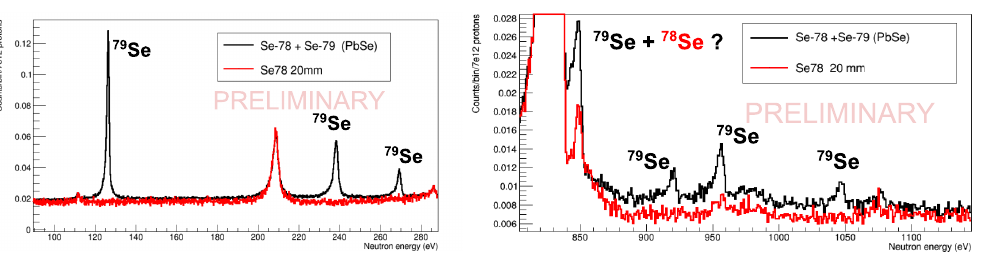
Figure 4. Preliminary (n, γ ) counting rates measured at EAR2 with the PbSe( 78 + 79 Se) sample in two neutron energy